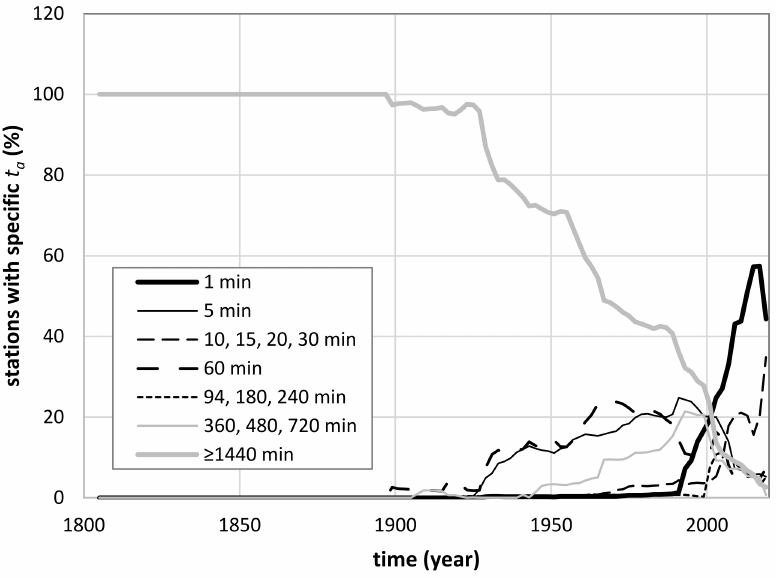
Figure 6. Percentage of rain gauge stations with specific temporal aggregation, t a , as a function of time. All the stations included in the analysis by Reference [35], except those located in Australia and Colorado (United States), are